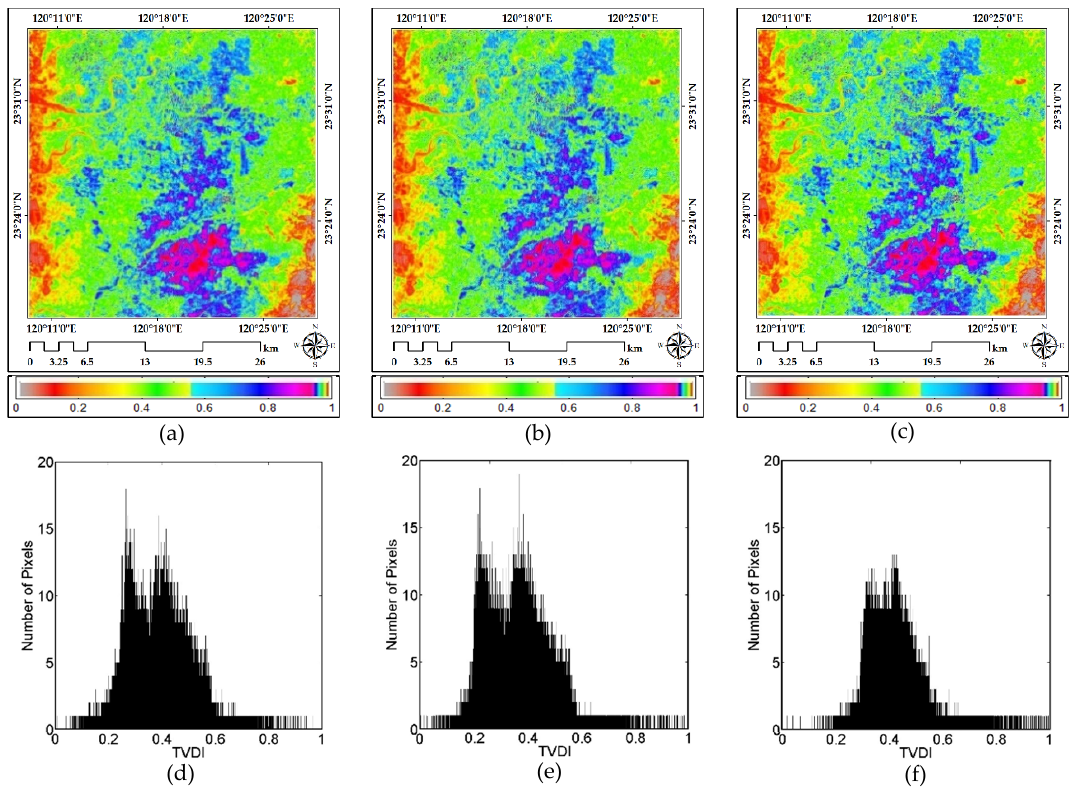
Figure 10. Same as Figure 8, but with the results of temperature vegetation dryness index (TVDI) on 18 January 2019.